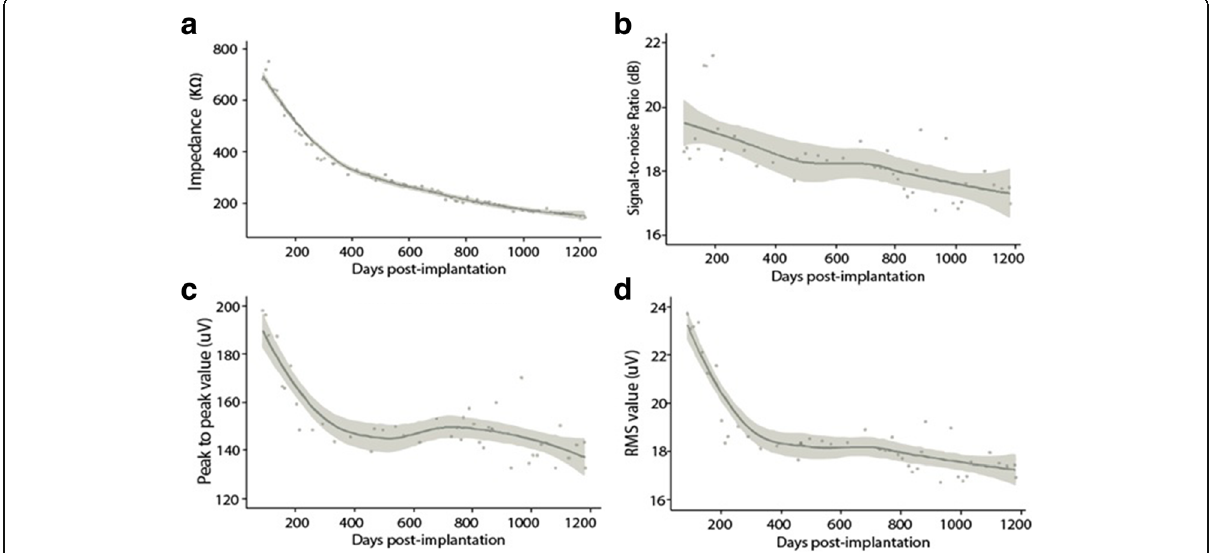
Fig. 3 a Average impedance over time. Each data point here shows the average impedance across two different reference electrodes on the MEA. Most of the sharp decline happened within the first 400 days. In ( b , c and d ), the results were summarized from the data collected in Task 2. b Signal-to-Noise Ratio (SNR) over time. Each data point shown here is the average SNR value of an experimental day. The SNR was stable in general with an average value at 18.28±0.25 dB throughout the length of the study, with a slight decline overall. c Peak-peak value of the detected TCs from the raw signal. Each data point presents the average peak-peak value of all the detected TCs from an experimental day. The Peak-peak value decreased the most during the first 400 days and the overall average throughout the study was 153.68±17.92 μ V. d RMS noise value of the raw signal. RMS value shared a similar temporal profile over the period of entire study compared to that of peak-peak value and SNR value. The overall average RMS noise was 18.78±1.89 μ V. In each figure, the line indicated the Loess regression result of the discrete values throughout the entire study, with 95% confidence intervals in each